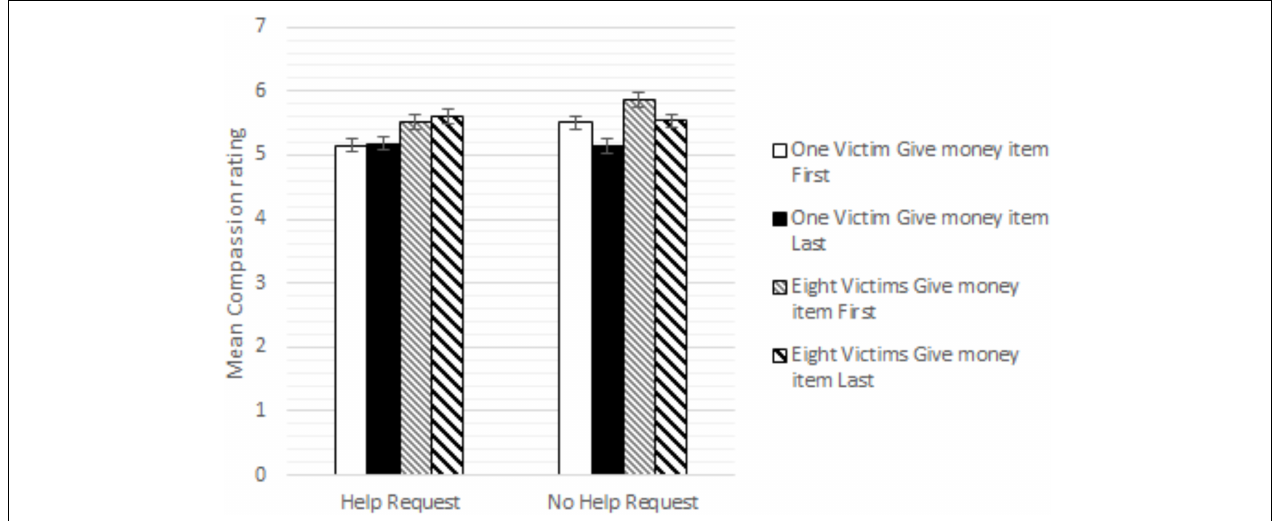
FIGURE 2 | Mean compassion toward the child (children) across conditions. Error bars are